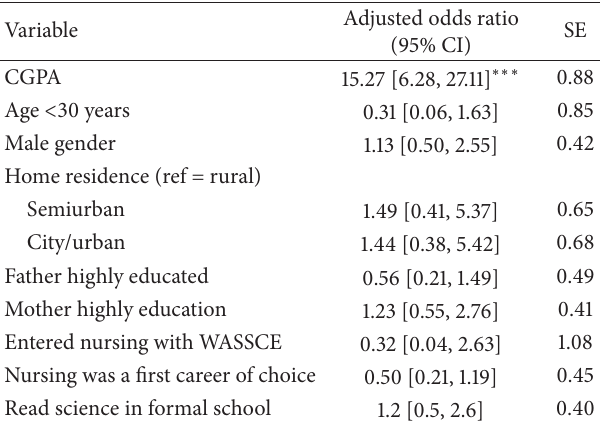
Table 5: Logistic regression analysis of influence of entry character- istics on performance in licensing